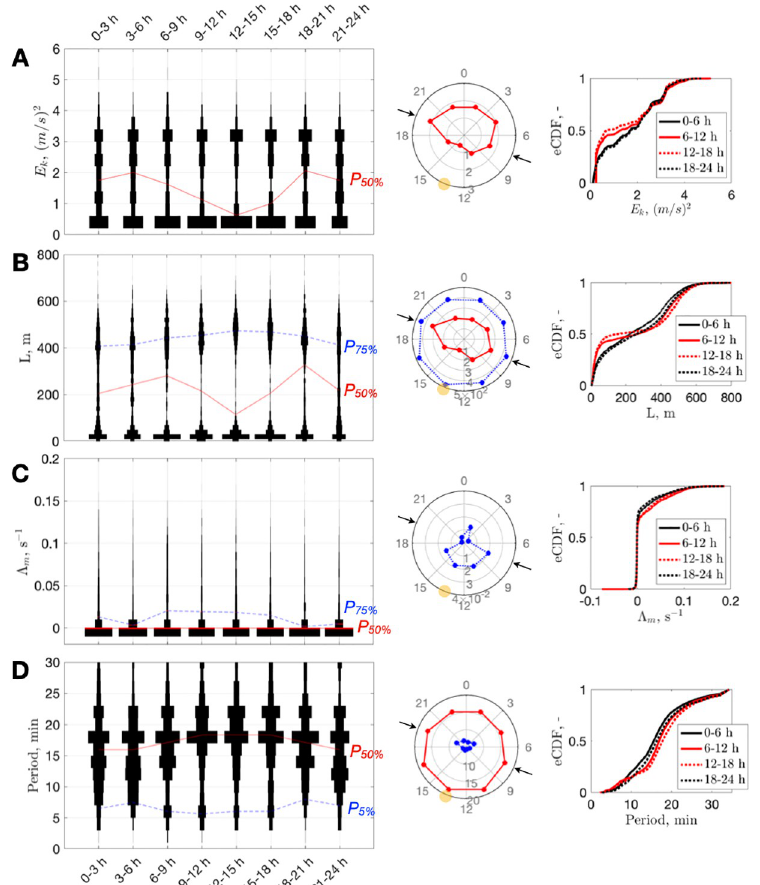
Fig 2. Diurnal narwhal behavior. Violin plots of (A) kinetic energy, E k ; (B) Euclidian distance, L ; (C) maximum Lyapunov exponent, Λ m ; and (D) dominant timescale distributions by hour of day (using 3 h bins) with red and blue curves connecting percentile levels ( P 50% and/or P 5,75% ). In the center column, the corresponding percentile levels are shown on a circular 24 h plot (representing the narwhal daily routine; yellow circle indicates the sun’s culmination time, 13:29; arrows indicate the time of sunset and sunrise on September 25, 2013 the middle date of the dataset). Right side: empirical Cumulative Distribution Function (eCDF), for the same quantities computed using 6 h bins (black represents “night”, red “day”).